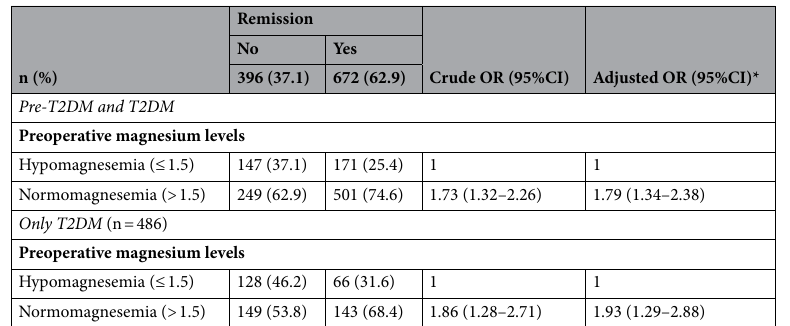
Normomagnesemia (>